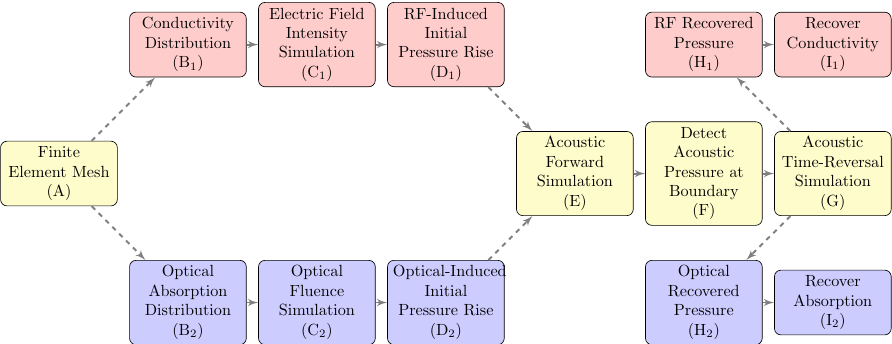
Figure 1. The similarities between key steps of the photoacoustic computed tomography (PACT, blue) and radio frequency (RF)-induced acoustic computed tomography (RACT, red) workflows, with methods that are shared represented in yellow. Step A represents the finite element mesh in Section 2.5, used for both types of simulation. Step B 1 is represented in Figure 9a, while step B 2 is represented in Figure 7a. Step C 2 uses the optical diffusion Equation (1). Step C 1 uses the electromagnetic wave Equation (5). The resulting pressure rise for the optical (D 2 ) and RF (D 1 ) radiations are represented by Figures 7b and 9b, respectively. The initial pressure propagates out to the boundary (E) via the scalar wave Equation (7). The data received by acoustic sensors at the boundary (F) can then be used in reconstruction algorithms (G) to recover the initial pressure. In this paper, a time-reversal algorithm is applied for reconstruction (Section 2.4). The reconstructed pressure is then divided by the intensity (I 2 , I 1 ) to recover the recover the absorption or conductivity for the optical and RF cases, shown in Figures 7c and 9c,